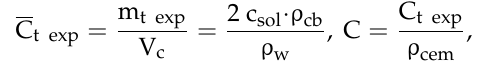
Figure 7. Profile Grinding Kit for concrete: ( a ) crushed concrete, ( b ) reference specimens from which concrete was collected by layers with this kit.